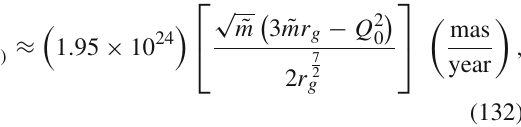
Table 1 The properties of the charged white dwarfs from Ref. [72] (given in geometric units) and the values of precessions inferred from Eqs. (128) and (132). For the case of precession in Weyl gravity, we M w / M